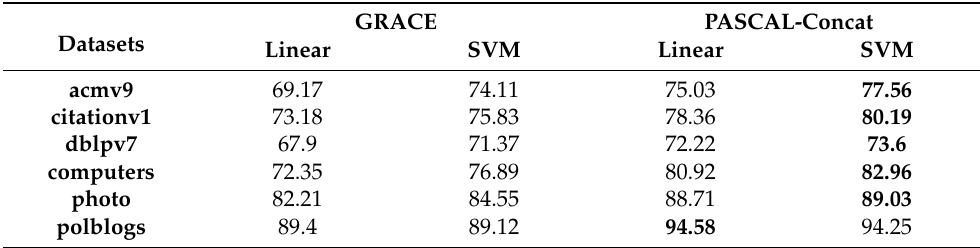
Table 6. The performance of GRACE and PASCAL-concat with different classifier. “Linear” and “SVM” represent the use of linear and SVM as node classifiers, respectively. Bold numbers represent the best results on different